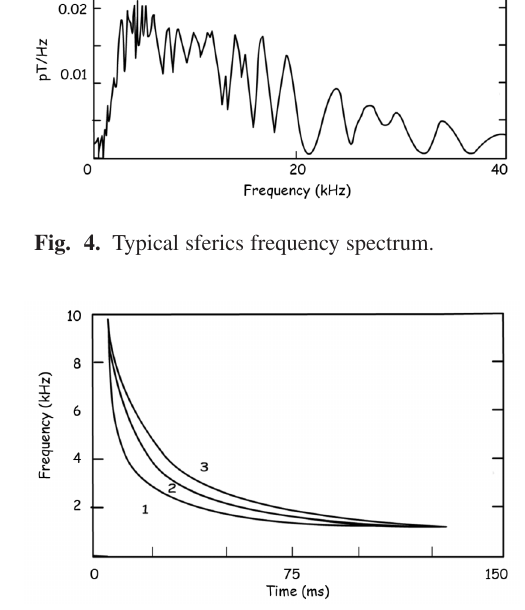
Fig. 5. Tweeks that traveled for different distances in the Earth-ionosphere waveguide. Shown for about 6000 km (1), 10000 km (2) and 40000 km (3) paths.